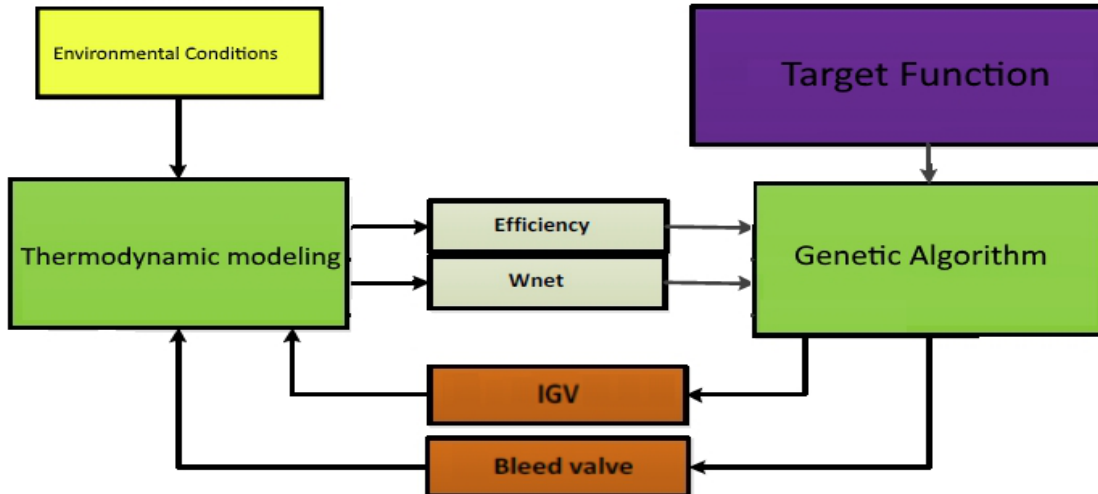
Figure 2. General Optimization Flowchart